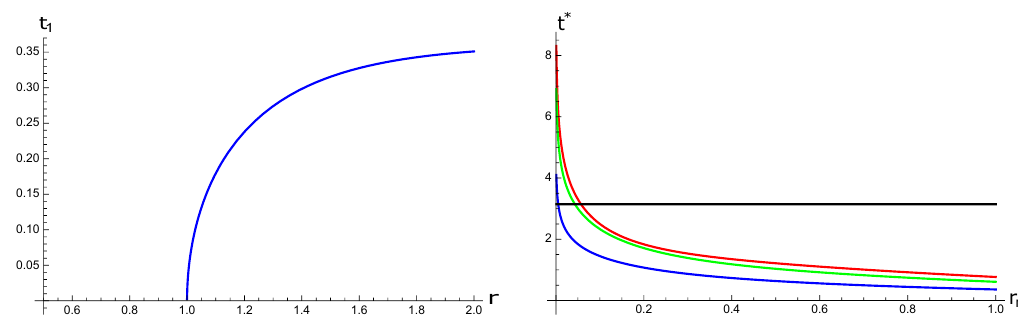
Figure 13 . Left: the angle t 1 as a function of radial position for B = 3. It vanishes at r = r m where the loop shrinks to zero size. Right: the asymptotic value of the angle t (cid:3) as a function of r m . Large loops on the boundary penetrate further in the bulk (smaller r m ). There is a saturation on how far in the bulk the disconnected string can go, where the line crosses t (cid:3) = (cid:25) , that is a maximal boundary size loop. The lines are for B = 0 : 6 ; 1 ; 3 from red to